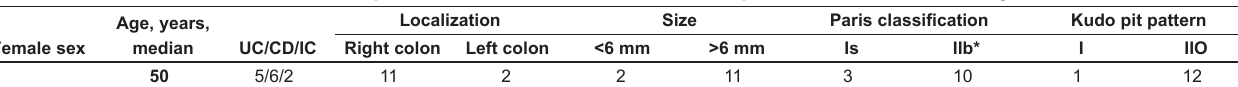
TAbLe 3 baseline characteristics and endoscopic features of serrated adenoma in patients with inflammatory bowel